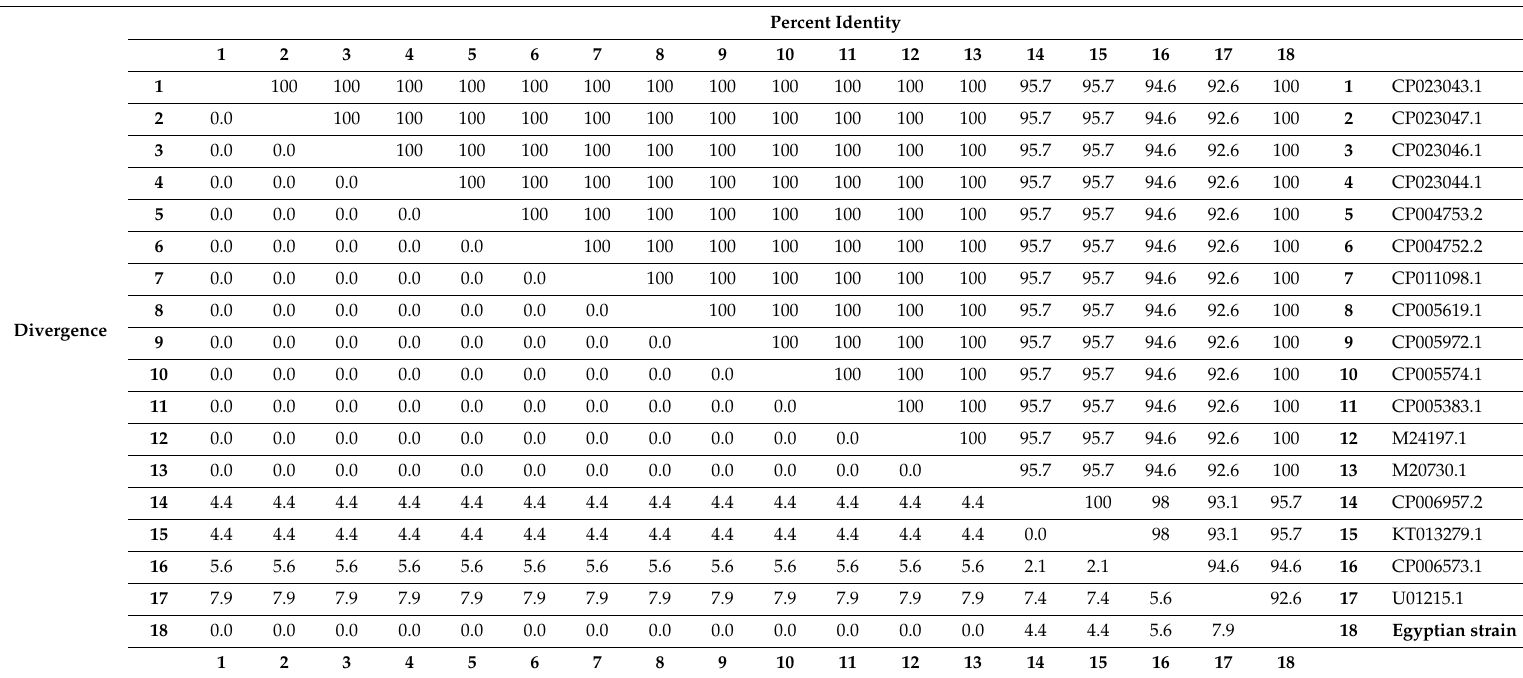
Table 7. Nucleotides and amino acid identity and sequence distance of M. haemolytica serotype A2 lkt C gene between the Egyptian strain and di ff erent strains uploaded in the